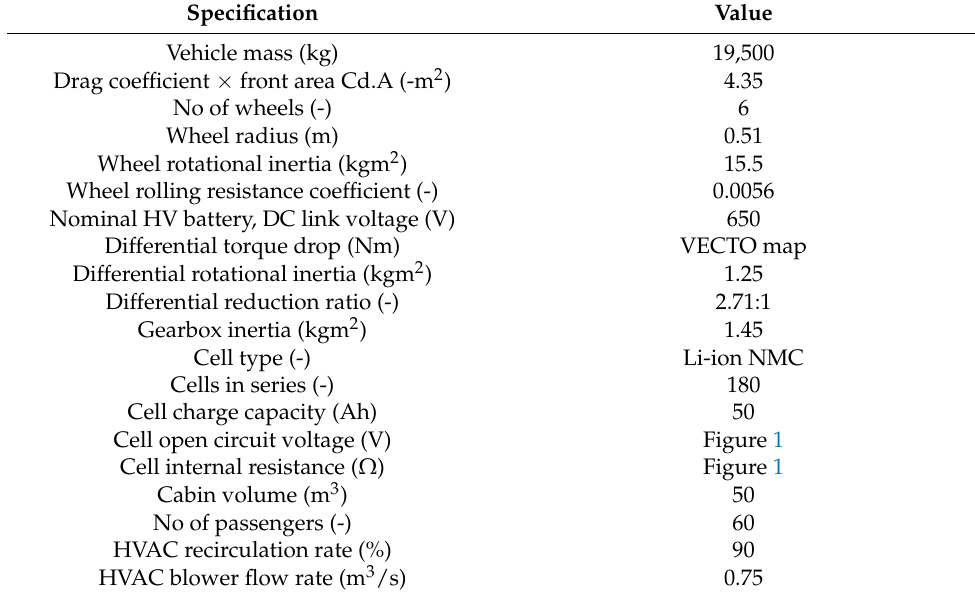
Table 2. Series hybrid coach use case vehicle specifications.